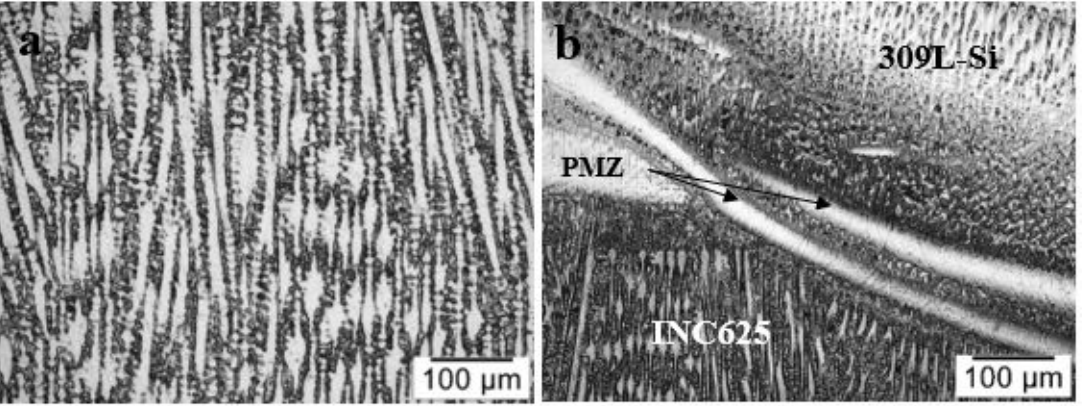
Figure 6. Microstructural aspects of the weld metal of the 309L-Si/INC625 welded joint: a) Dendritic on 309L-Si weld metal, b) PMZ on 309L-Si/INC625